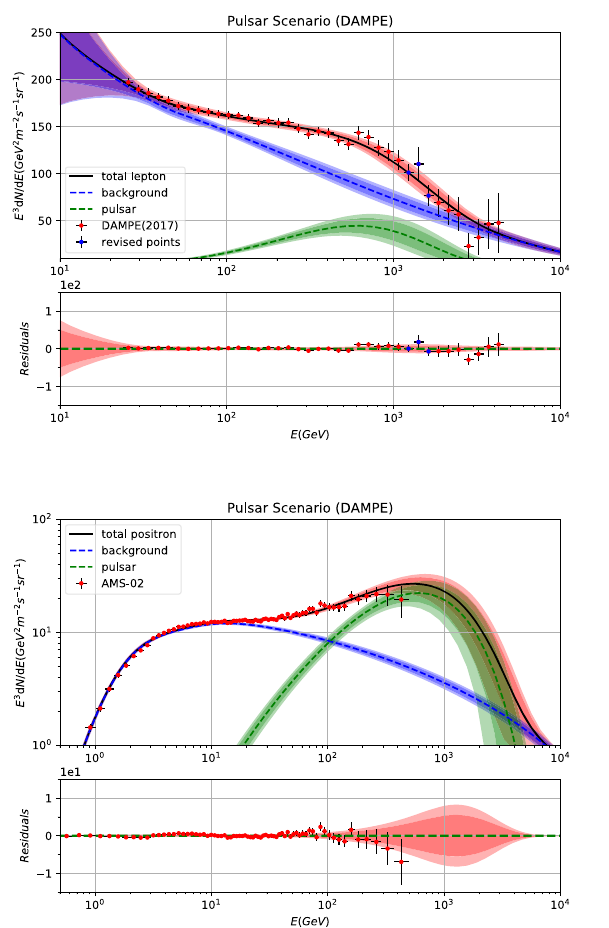
pulsar (green), are also shown in the figure. Different from Figs. 1 and 2, all the experimental data which did not participate in the global fitting has not been not